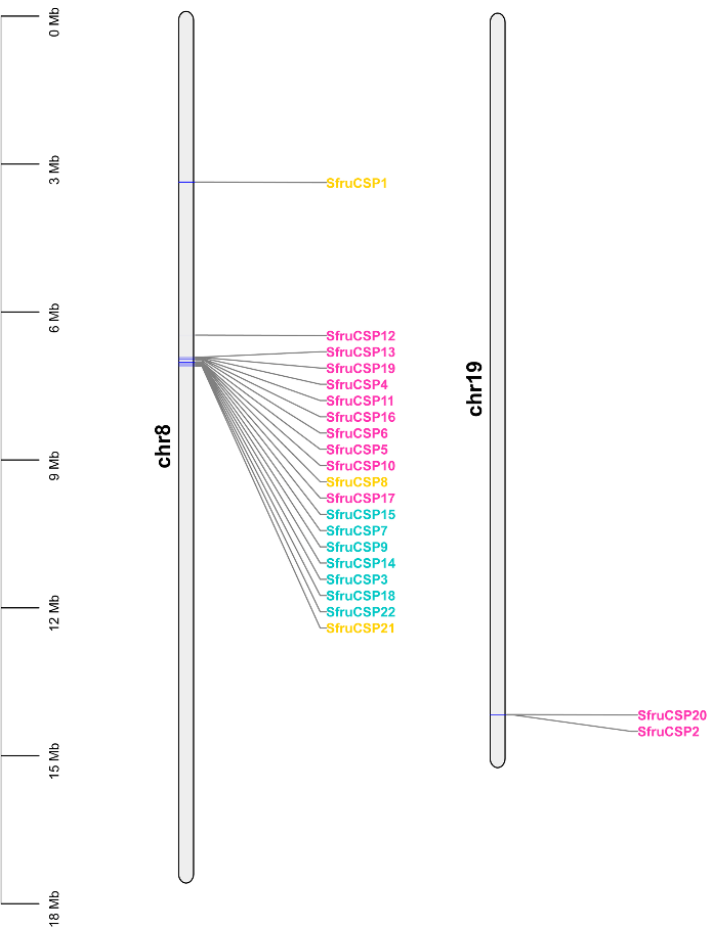
Figure 4. Chromosomal localization of the SfruCSP genes based on the genome data of S. frugiperda . Different colors of gene names indicate CSPs from specific clusters as indicated in Figure 2: orange, Cluster 1; pink, Cluster 2; bright green, Cluster 3; cyan, Cluster 4.